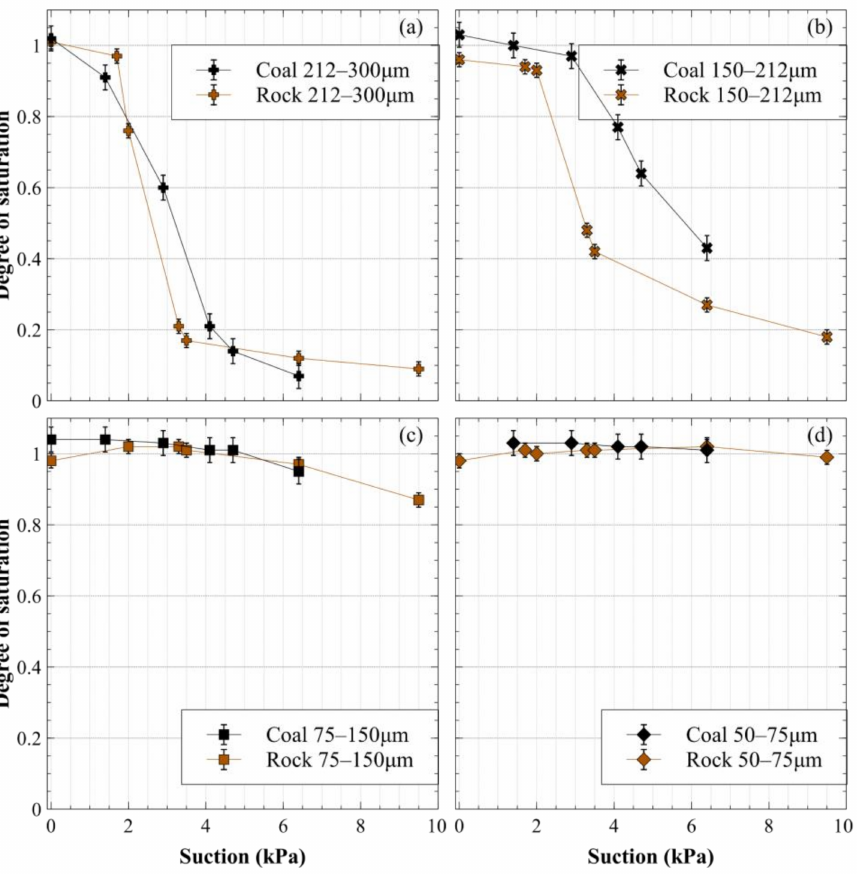
Figure 8. Drying path of the water retention curves of crushed coal and crushed rock expressed as the saturation degree vs. suction: ( a ) 212–300- µ m size fraction; ( b ) 150–212- µ m size fraction; ( c ) 75–150- µ m size fraction and ( d ) 50–75- µ m size